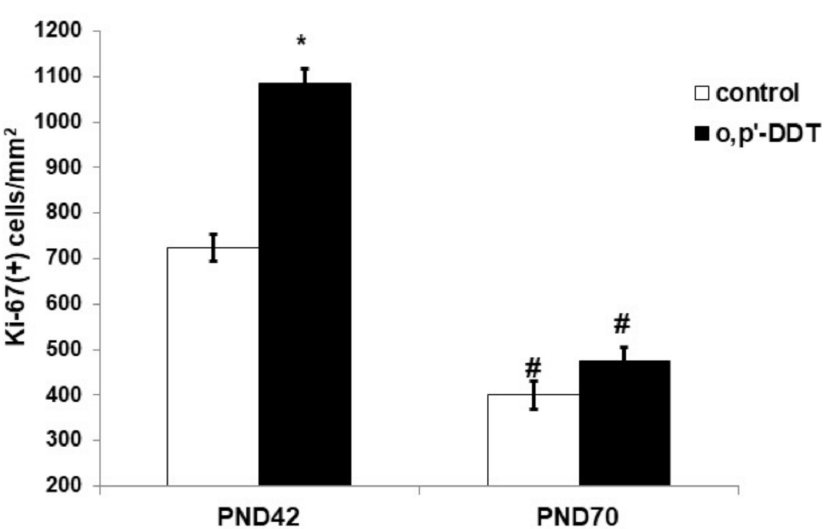
Figure 2. Proliferative activity of the glomerulosa cells in the control and o,p-DDT exposed rats. Data are shown as mean ± S.E.M. PND, day of postnatal development; p < 0.05 compared to the control (*), compared to PND42 (#).